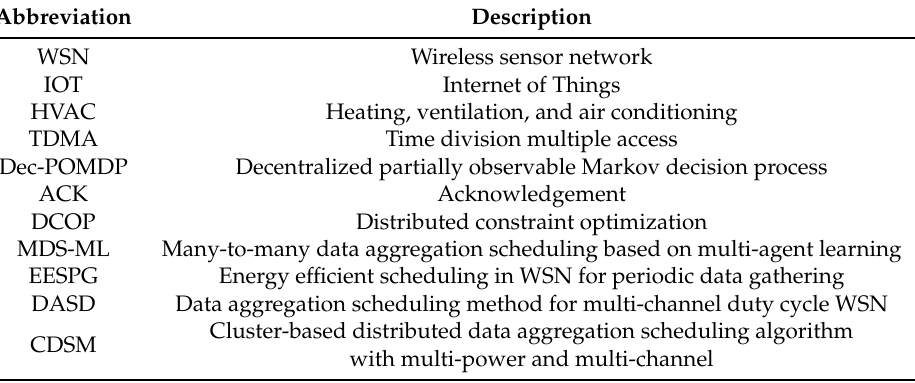
Table A1. Table of